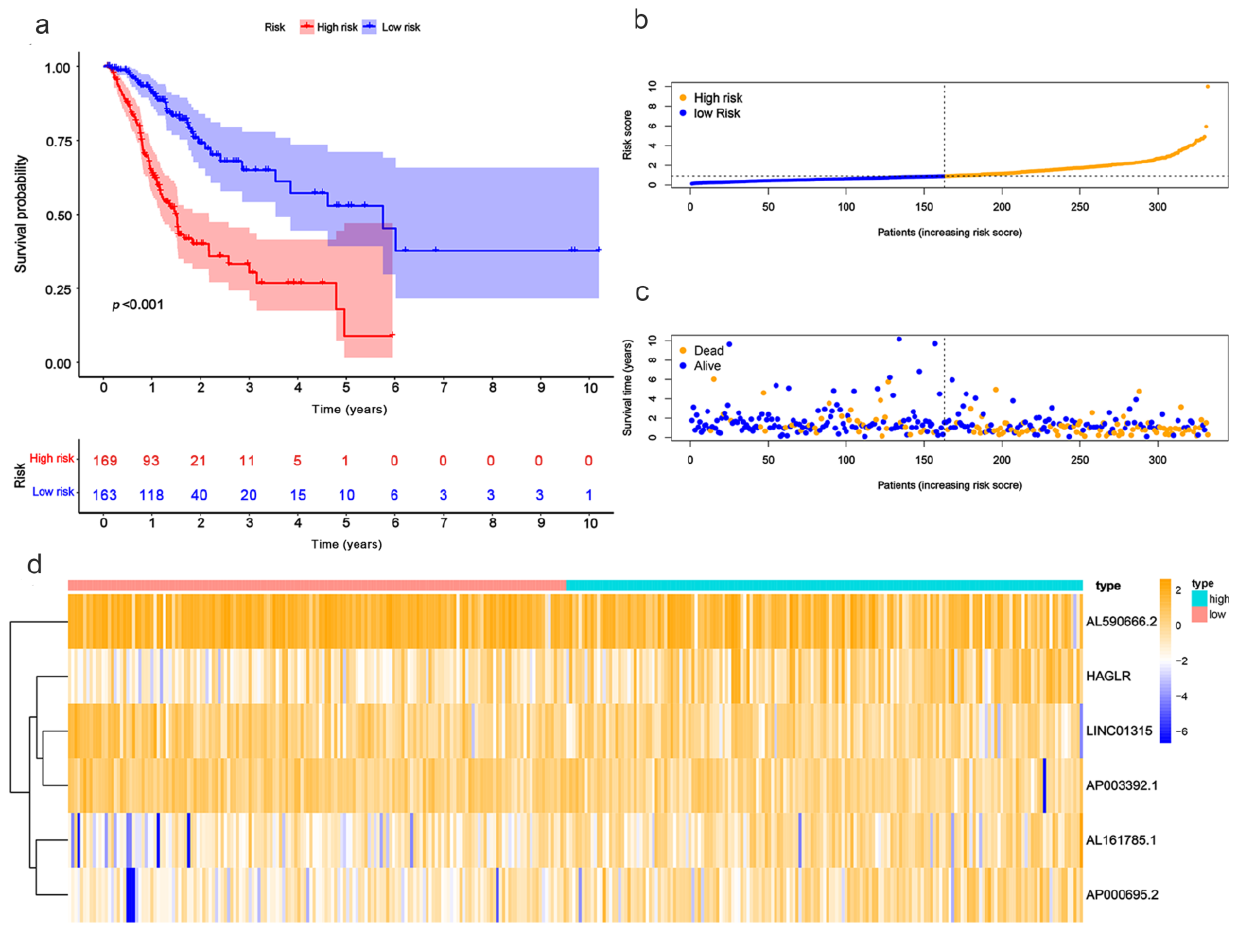
Figure 3. Evaluation of the prognostic value regarding the six PRlncRNAs’ risk models. ( a ) Kaplan– Meier OS curves with respect to the high- and low-risk groups. ( b ) The risk curves, as based on the patient risk scores. ( c ) Scatter plot, which was established according to the patients’ survival statuses. The blue dots represent survival, and the orange dots represent death. ( d ) A heatmap that shows the differential expression levels of PRlncRNAs with respect to the high- and low-risk